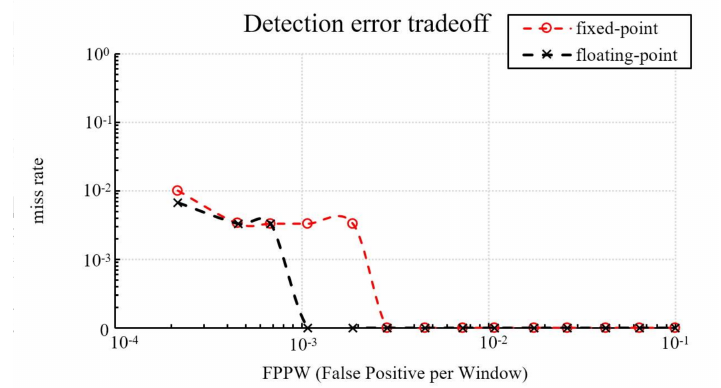
Detection accuracy of fixed-point and floating-point implementations on the MIT pedestrian